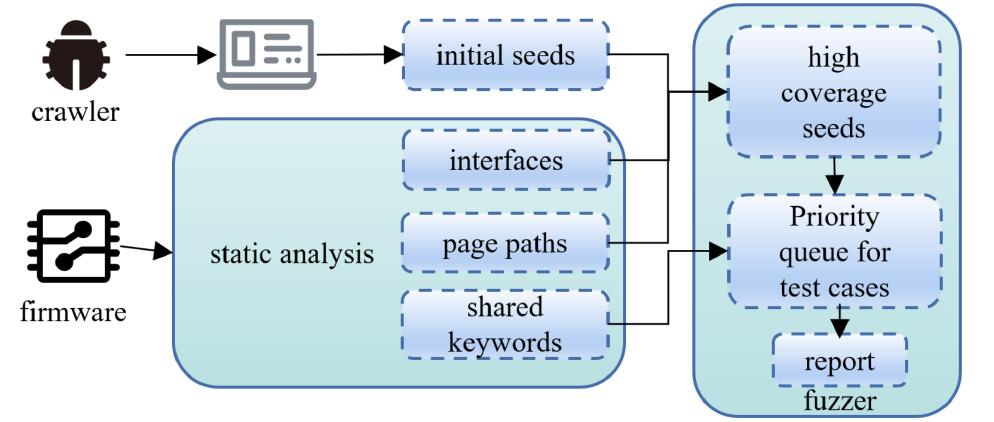
Figure 5. Architecture of